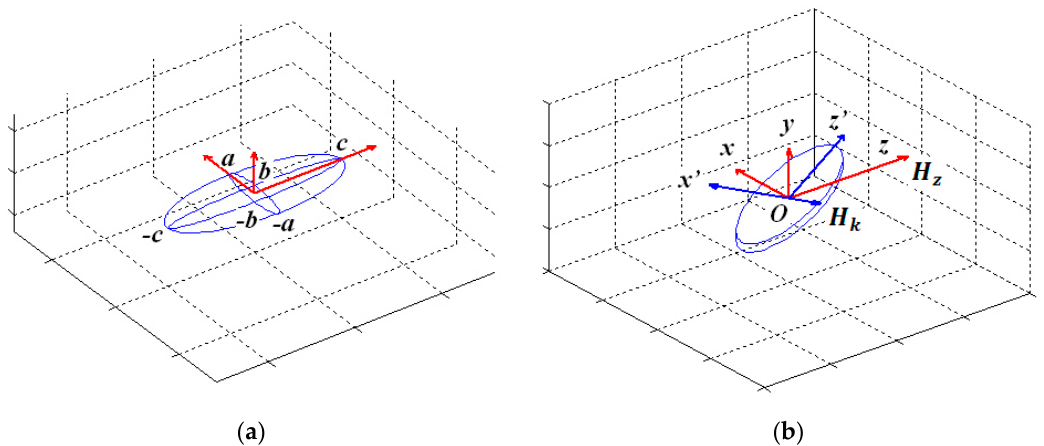
Figure 3. Geometry of the approximation of the shape of [Ti/FeNi] 6 /Ti/Cu/Ti/[FeNi/Ti] 6 multilayered GMI element by ellipsoid with 2 a = 0.4 mm, 2 b = 1.2–0.5 µm and 2 c = 10 mm dimensions ( a ). A new coordinate system for taking into account the rotation of the ferromagnetic GMI element in the xOz plane ( b ).